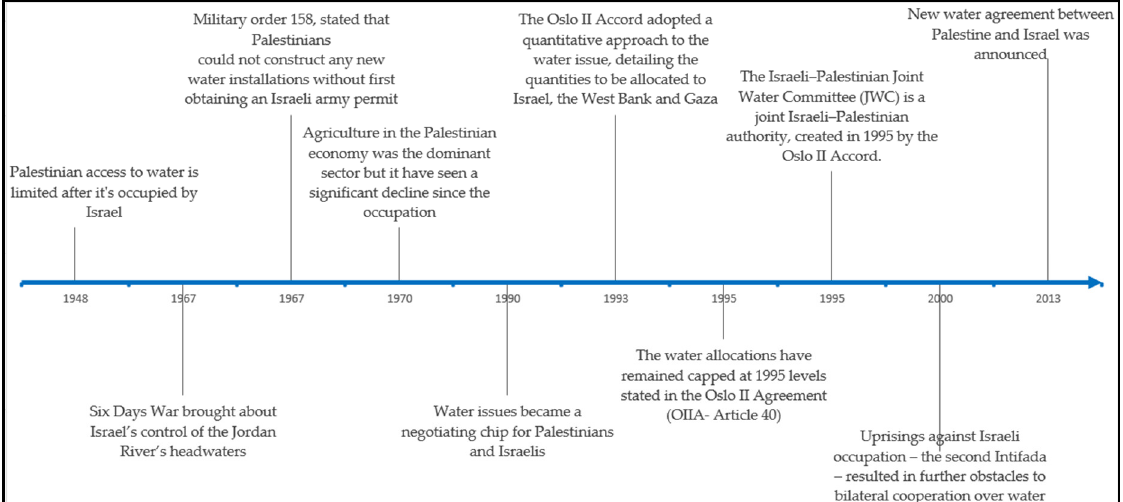
Figure 5. Timeline of Palestinian-Israeli water conflict and agreements. Source: Created by authors, data cited in the text.